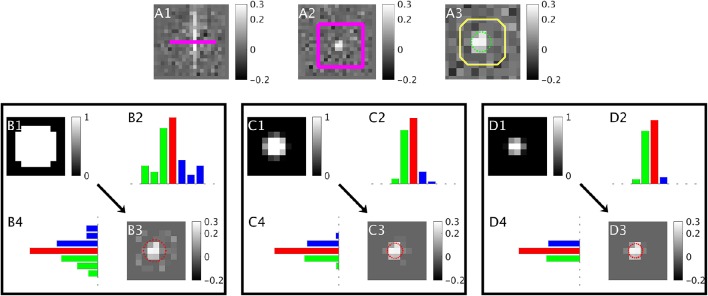
A depiction of the iterative ICF method over the first three iterations. (A) Input QSM in parallel (A1) and a cross sectional slice (A2) with the slice location and neighborhood overlaid in pink. (A3) shows a close-up of the neighborhood region with the true vein boundary in green and a dilated vein mask in yellow. χ^background is estimated from outside the dilated mask. (B1) shows the initial partial volume values taken from the dilated vein mask. (B3) is the “vein-only image” produced by subtracting the background component from the input QSM (A3) using the partial volume map. (B2,B4) are the column and row summations respectively of (B3), red shows the centermost column (highest cumulative intensity), green and blue correspond to the segment areas used to estimate the vein geometry. The geometry estimated from (B3) is overlaid in red. This geometry is used to provide the partial volume in the next iteration (C1). The process is repeated in (C,D).